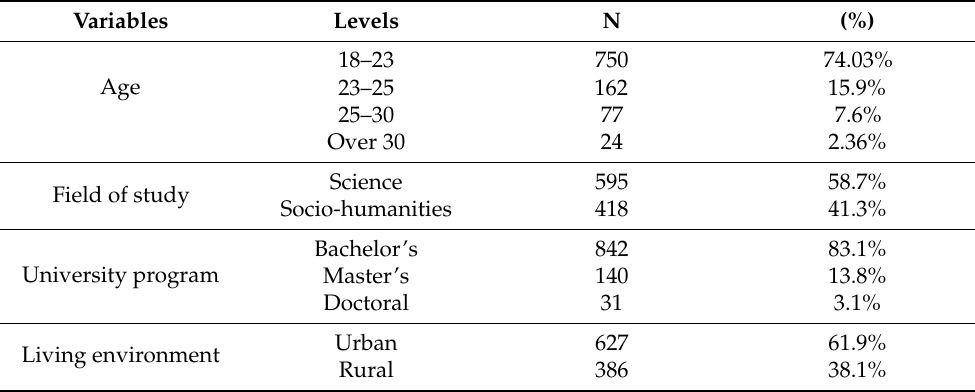
Table 2. The structure of the study